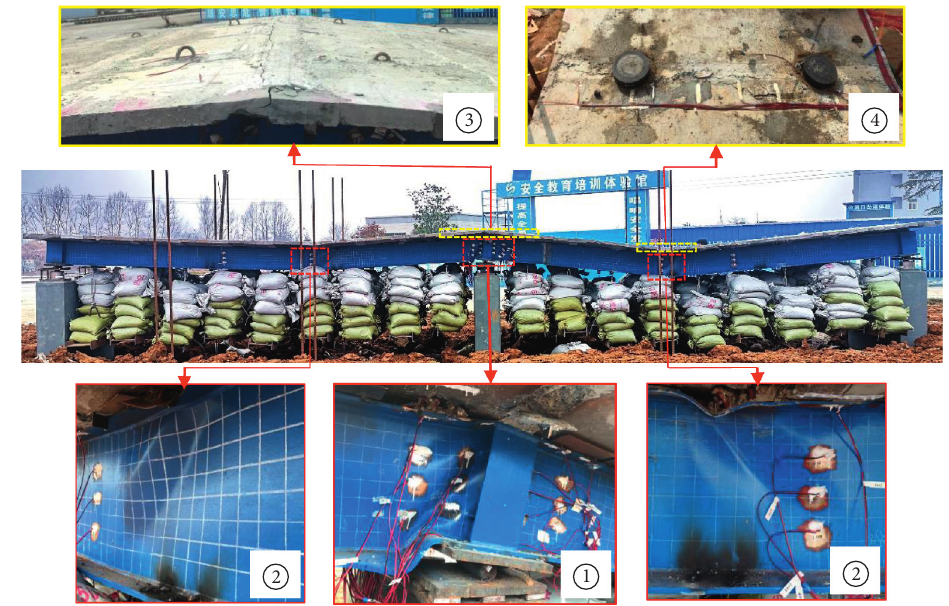
Figure 7: Failure pattern of the bridge model (view of internal girder).